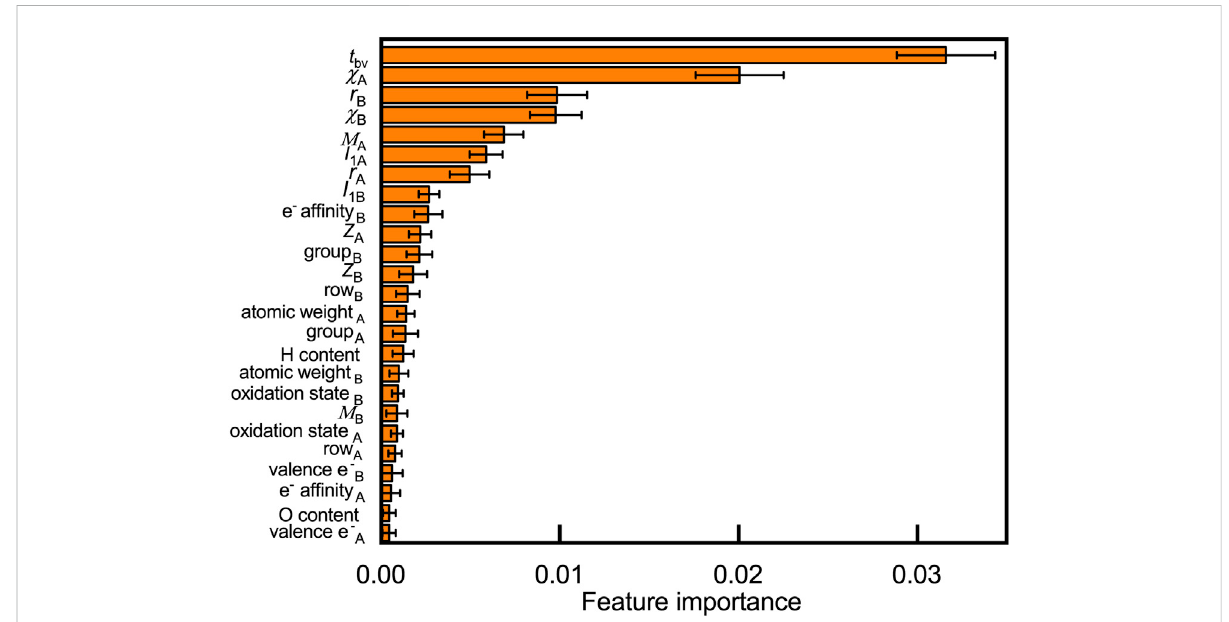
FIGURE 5 Feature importance to classify oxyhydrides stability based on the permutation method using the random forest model, where 25 features, including20basicelementalproperties(e.g.,Shannonionicradius r ,Paulingelectronegativities χ ,Mendeleevnumber M ,atomicnumber Z ,electrons valence e − :the number of valence electrons and I 1 :the fi rst ionization energy)and fi ve structural/compositional features (e.g., tolerance factor t bv , H and O content in composition) are considered. Subscripts of symbols denote corresponding properties of elements at A and B sites, respectively. Errors bars indicate the standard deviation upon shuf fl ing